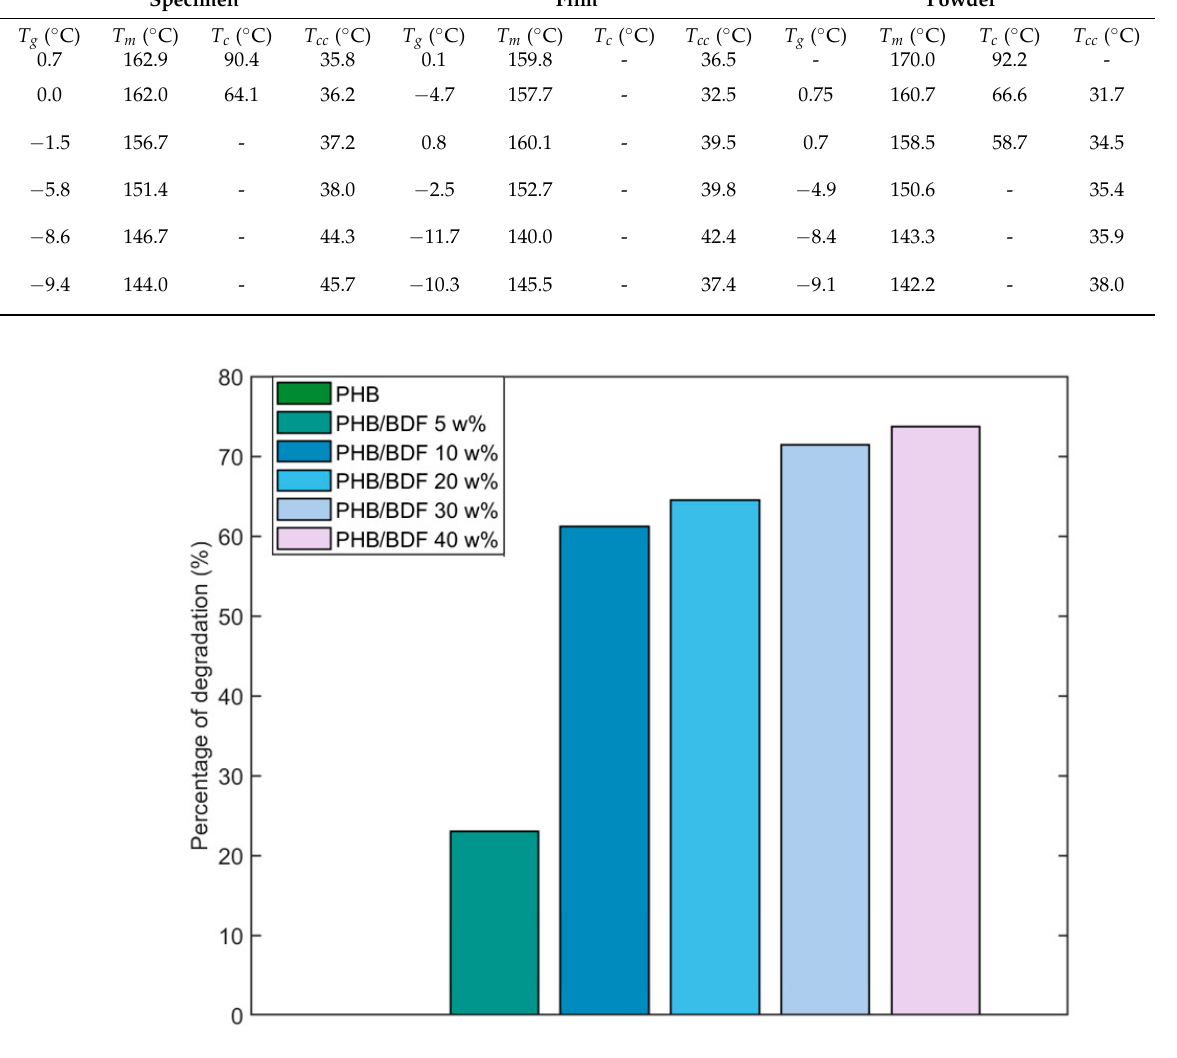
Figure 2. Degradation of specimens of PHB/BDF blends in a NaOH solution (0.25 M) during 32 h.